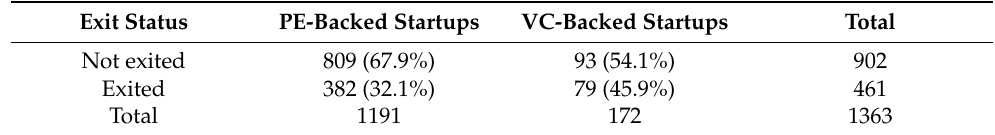
Table 7. PE and VC-backed Startups by Exit Status. Exit